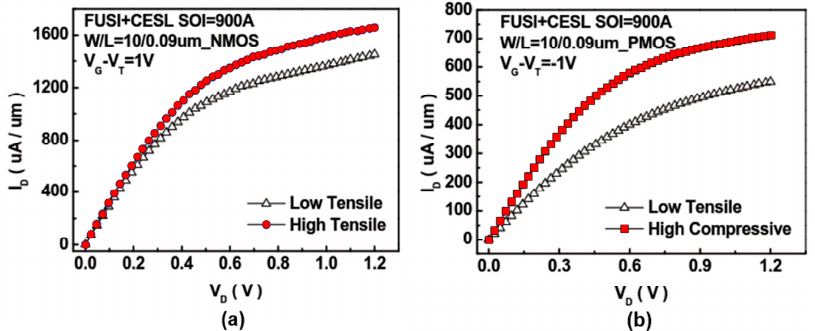
Figure 13. Comparison of I D - V D diagrams in conducting elements subjected to different layer strains: ( a ) NMOS and ( b ) PMOS [12].